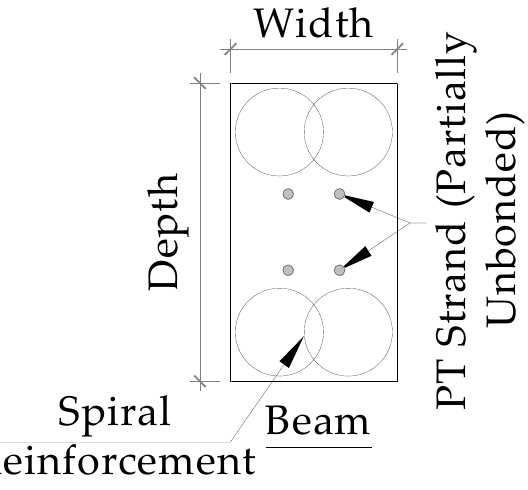
Figure 13. PT strand placed closer to the center and partially unbonded. Cheok and Lew (1994) [33] experimented using two specimens (Figures 14 and 15), similar to in phase II. The only change was that the prestressing steel was unbonded at the joint region. Both specimens failed in same way. Failure was due to post-tensioning steel yielding, crushing of concrete, and a gap opening at the column and beam interface. The width of the gap opening was not affected by partially debonding prestressing steel. The specimen strength exceeded that of its monolithic counterpart. Moving post-tensioning steel closer to the centroid did not have any adverse effect on connection strength. The precast assembly was found to be more ductile than its monolithic counterpart. The energy dissipation was improved compared to fully bonded post-tensioning steel. Total energy dissipation for the precast post-tensioned specimen was greater than for the monolithic specimen because of the higher displacement ductility achieved by the precast specimen. Overall, the precast connection performed well, but the energy dissipation was still around 60% compared to its monolithic